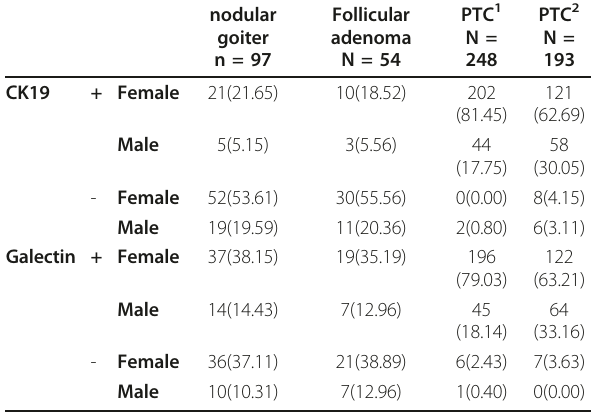
Table 3 Immunohistochemistry results of CK19 and Galectin-3 in papillary thyroid carcinoma (PTC) with or without lymphatic metastasis and other